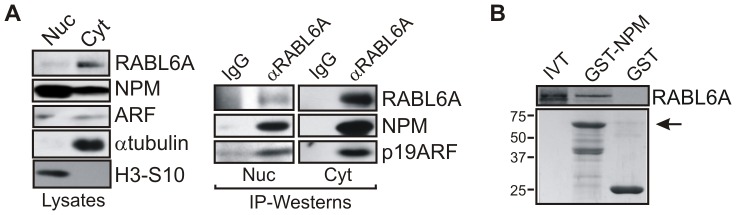
RABL6A associates with NPM in vitro and in vivo.(A) Endogenous complexes between RABL6A with NPM and ARF in p53−/− MEF nuclear (Nuc) and cytosolic (Cyt) fractions were identified by IP-Western blotting using control IgG versus RABL6 antibodies (right panel). Total protein levels in nuclear versus cytosolic fractions are shown (left), with phosphorylated histone H3-S10 and α-tubulin serving as fractionation controls for the nucleus and cytosol, respectively. (B) Top, In vitro binding of 35S-labeled in vitro translated (IVT) RABL6A to GST-NPM was detected by autoradiography. Bottom, levels of input GST and GST-NPM proteins indicated by Coomassie blue gel staining (arrow denotes full-length GST-NPM).